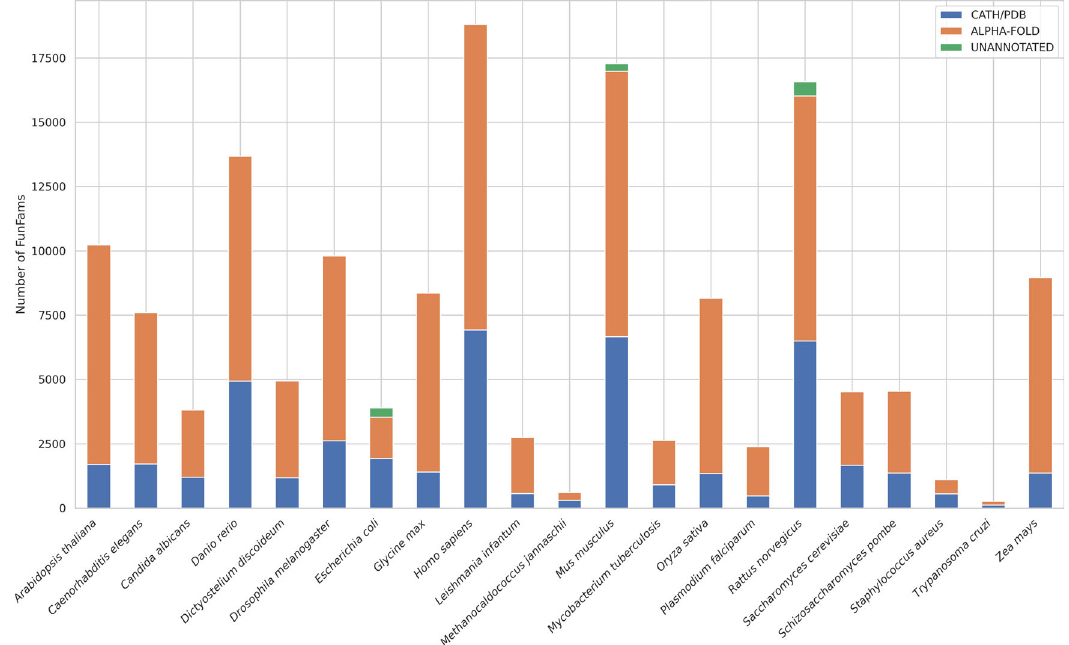
Fig. 5 Structural coverage expansion of CATH FunFams by AlphaFold domains. Initial coverage by CATH/PDB (blue), additional coverage by AlphaFold2 models (orange) and unannotated